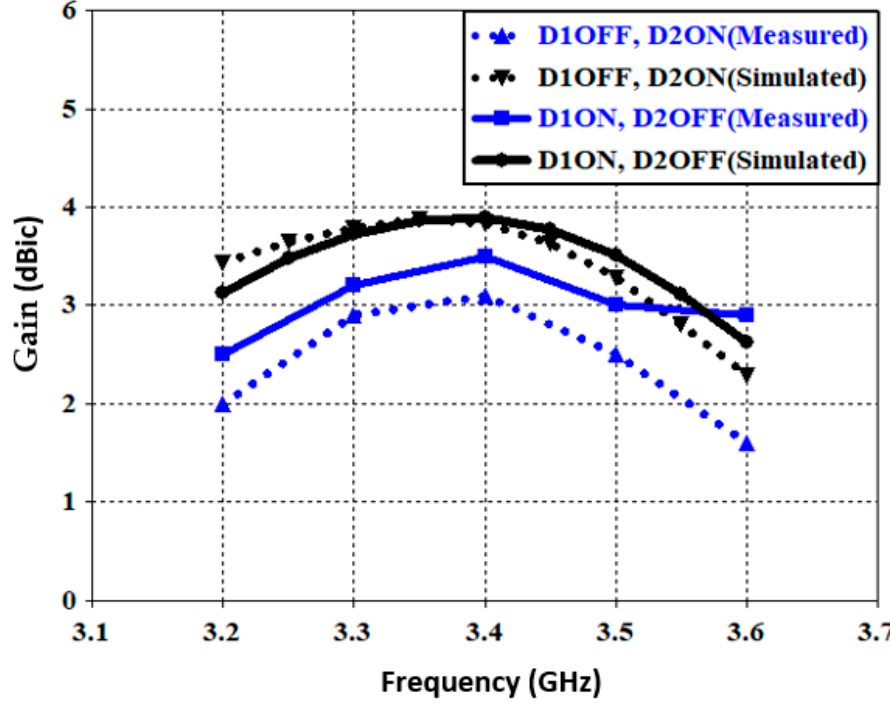
Figure 10. Measurement and simulation results for maximum gain for the proposed reconfigurable antenna.